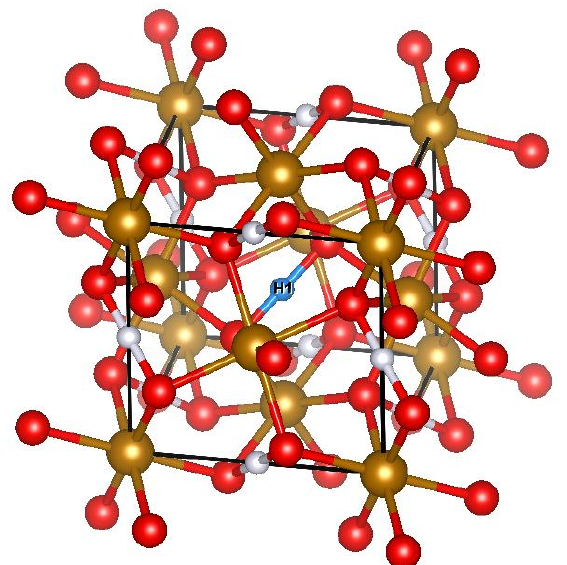
Figure 1. (Color online) Crystal structure of FeO 2 H. The space group is Pa ¯3. Iron and oxygen ions are shown by bronze and red colors, respectively. Central hydrogen is denoted H1 and shown by cyan, while the rest of H are shown by light grey. All hydrogens are equivalent in this crystal